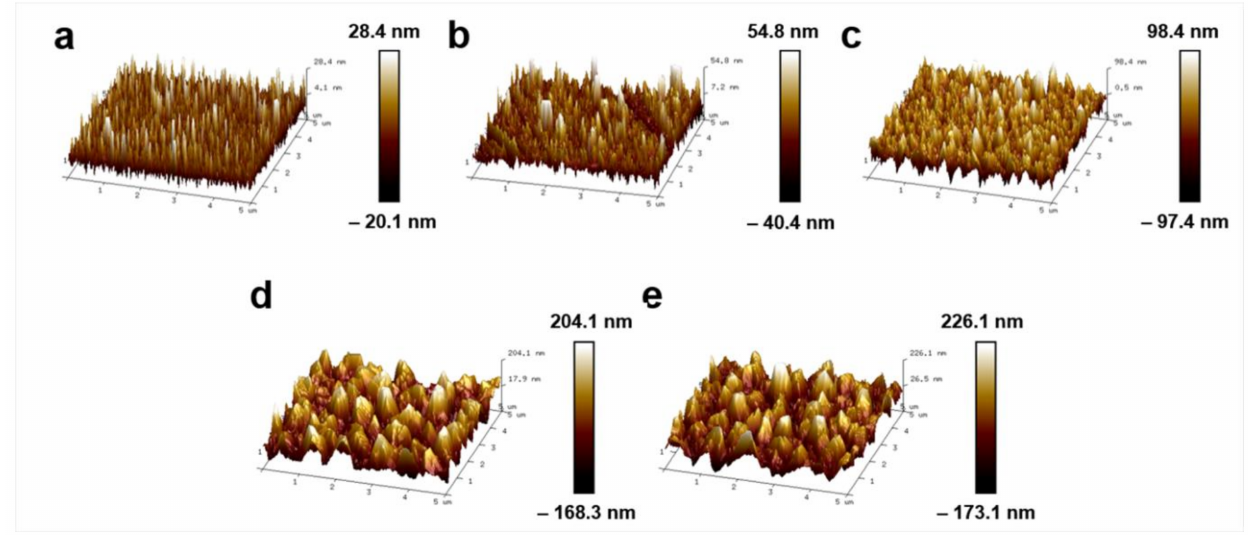
Figure 4. The AFM images of the Al films with different deposition time: ( a ) RT, ( b ) 100 ◦ C, ( c ) 200 ◦ C, ( d ) 300 ◦ C, ( e ) 400 ◦